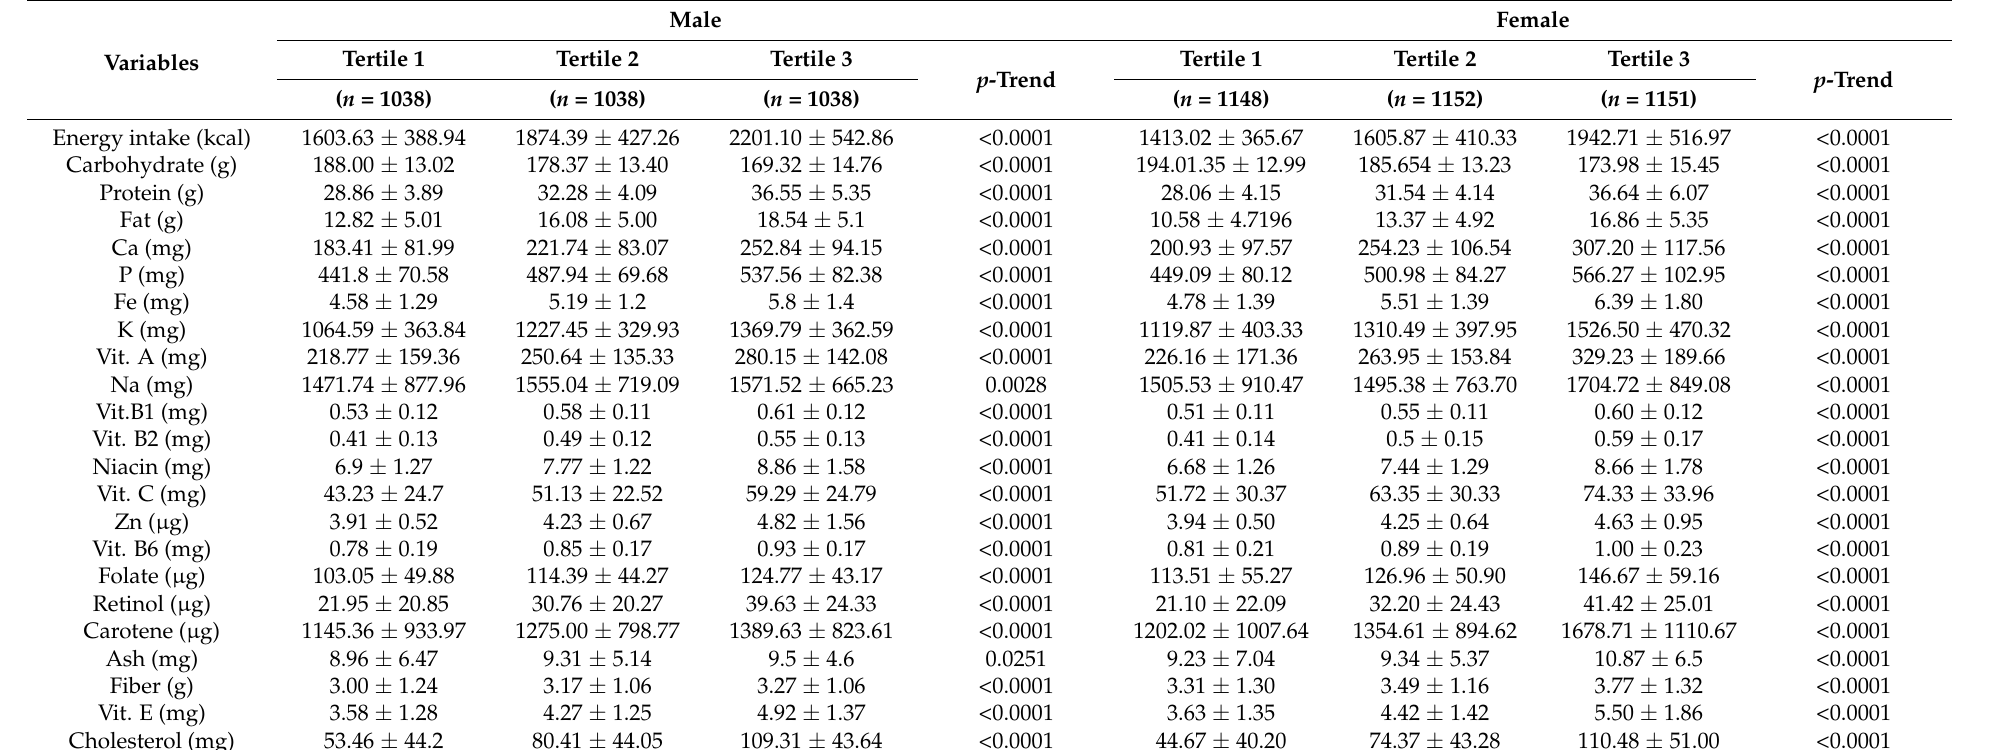
Table 2. Nutrient densities of participants according to seafood-intake